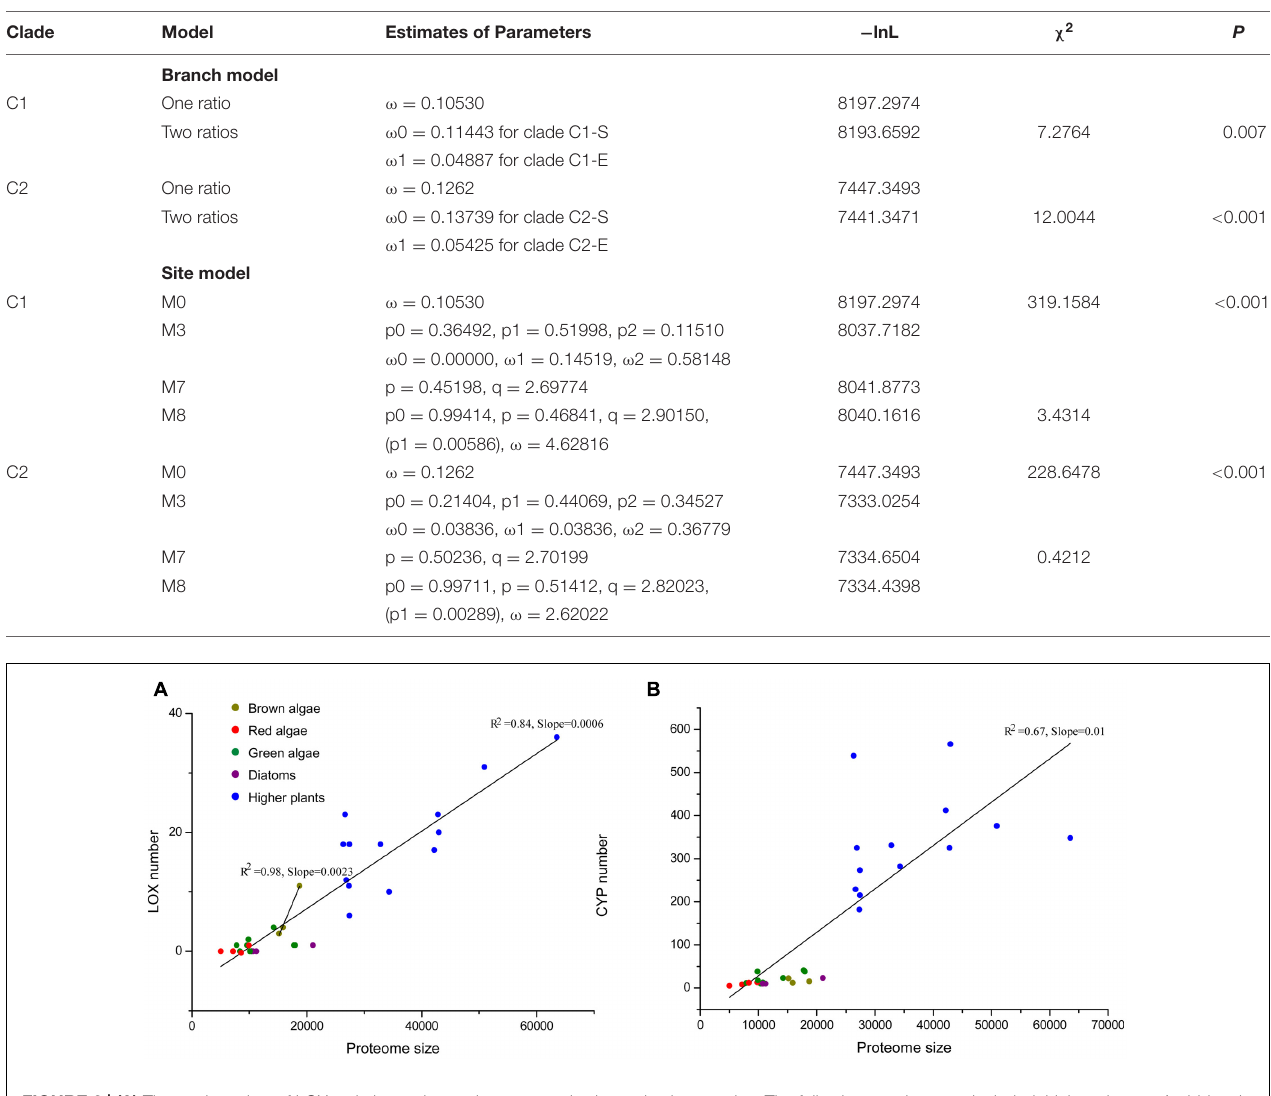
TABLE 2 | Summary statistics for detection of selection using branch and site